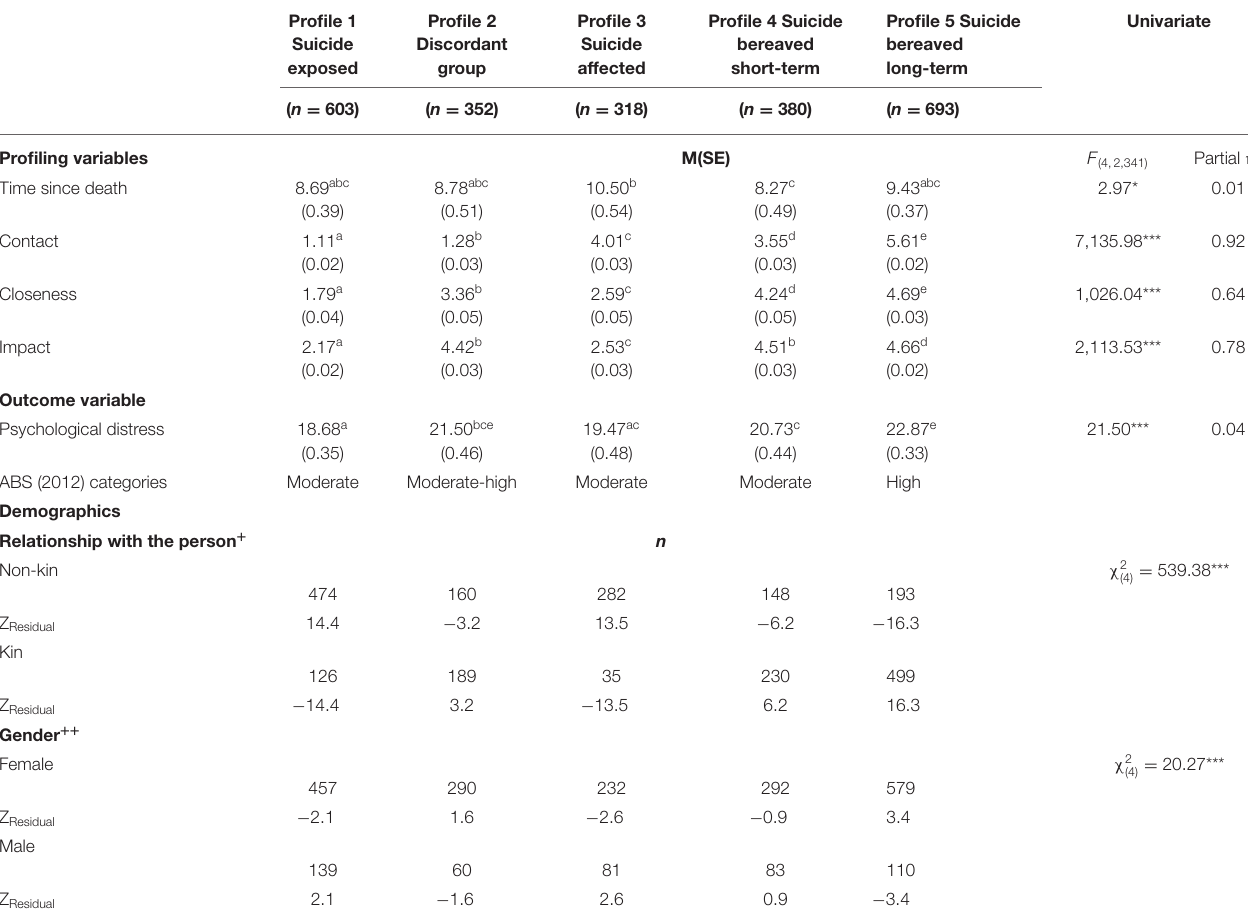
TABLE 3 | Means, standard errors (SE), and mean differences or distributions across five survivorship